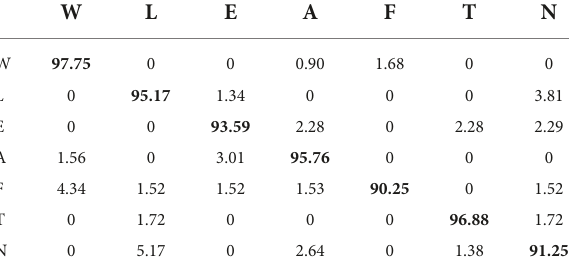
TABLE 5 Confusion matrix with